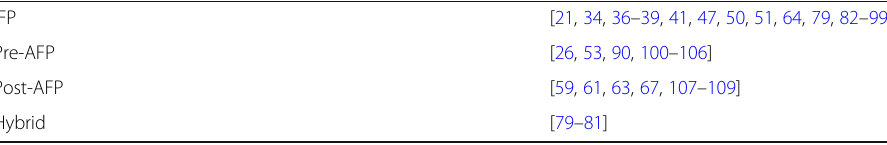
Table 1 A fuzzy system with the localization classification